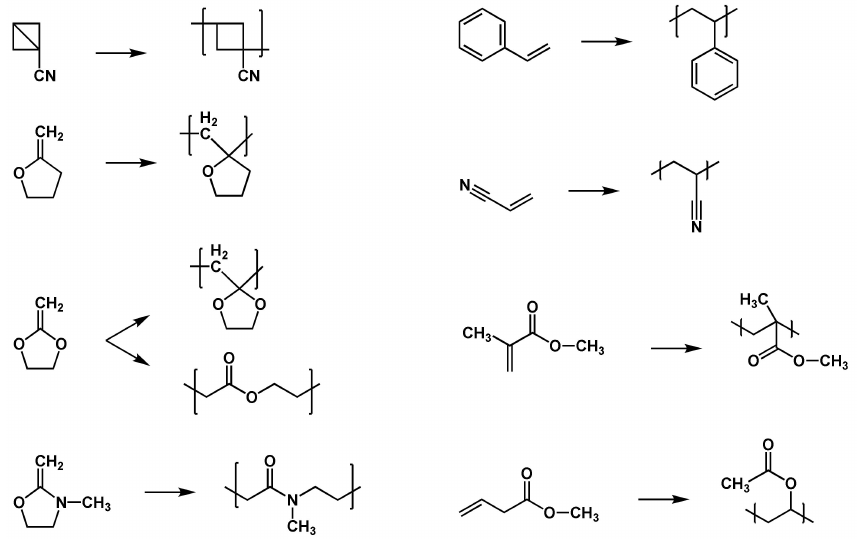
Figure 4. Representation of the chemical structures of monomers for free-radical polymerizations and of the corresponding repetition